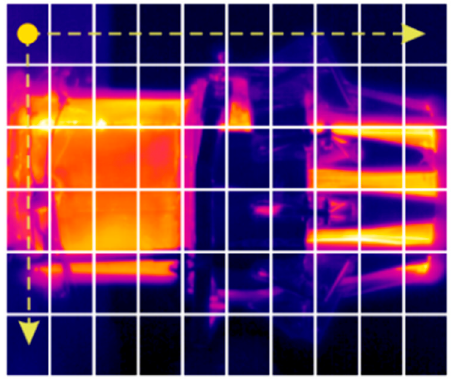
Figure 17. Thermal anomalies correctly classified by the Kohonen network.